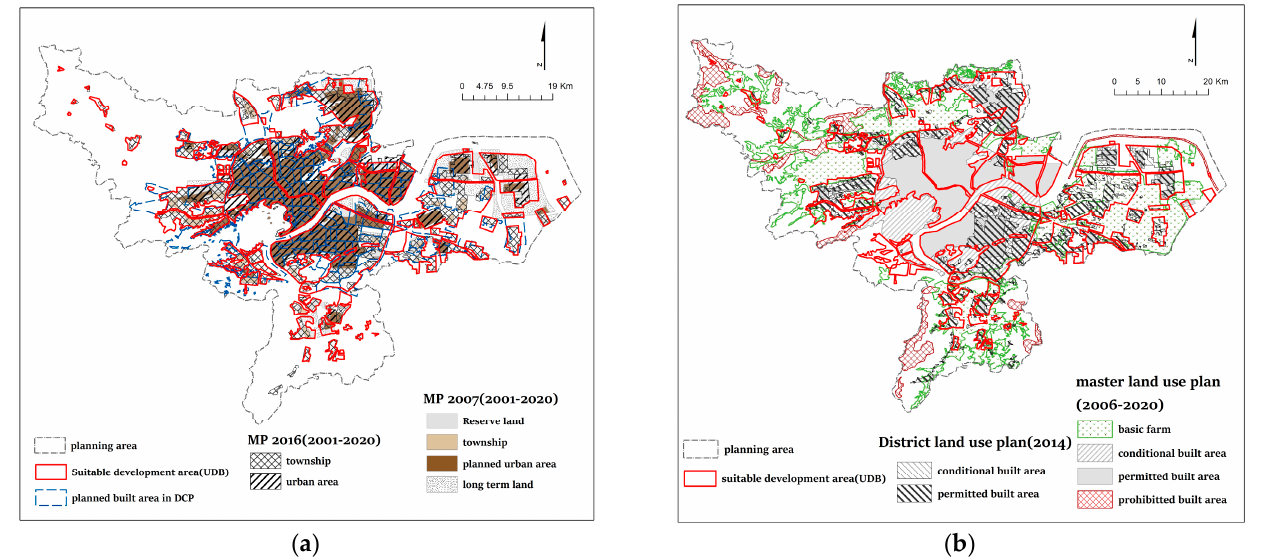
Figure 3. ( a ) The spatial plans of Hangzhou; ( b ) the land use plans of Hangzhou.